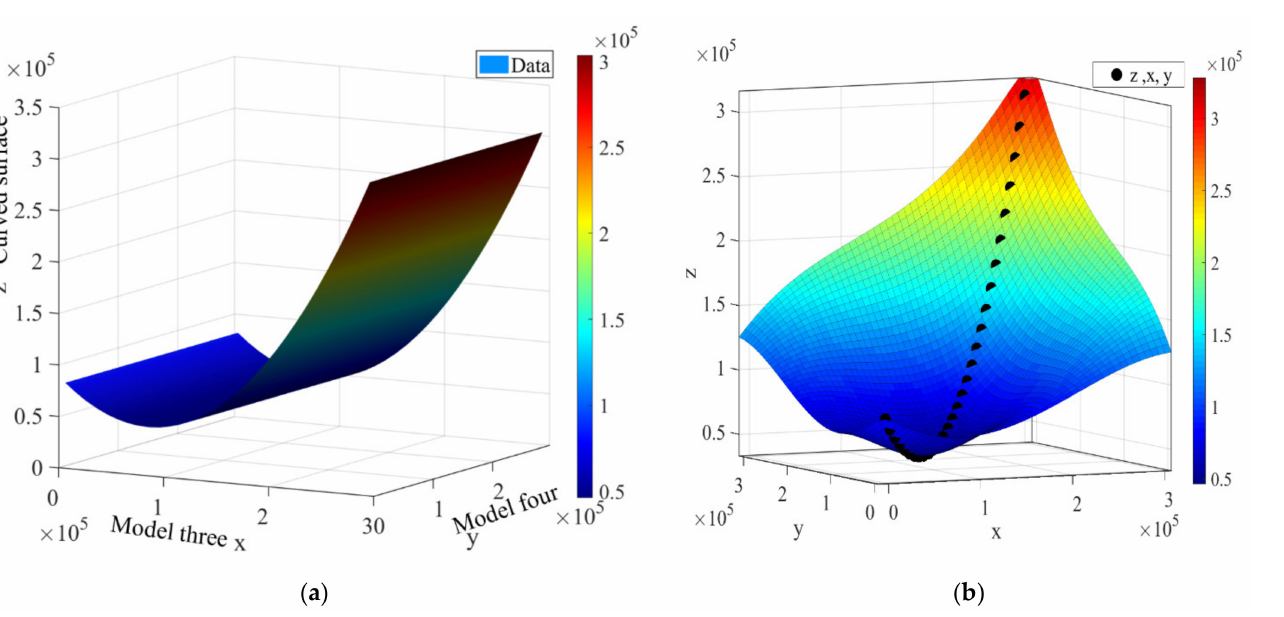
Figure 12. Model analyses 3 and 4: ( a ) Environmental impact and economic cost curved surface analysis; ( b ) Interpolation approximation